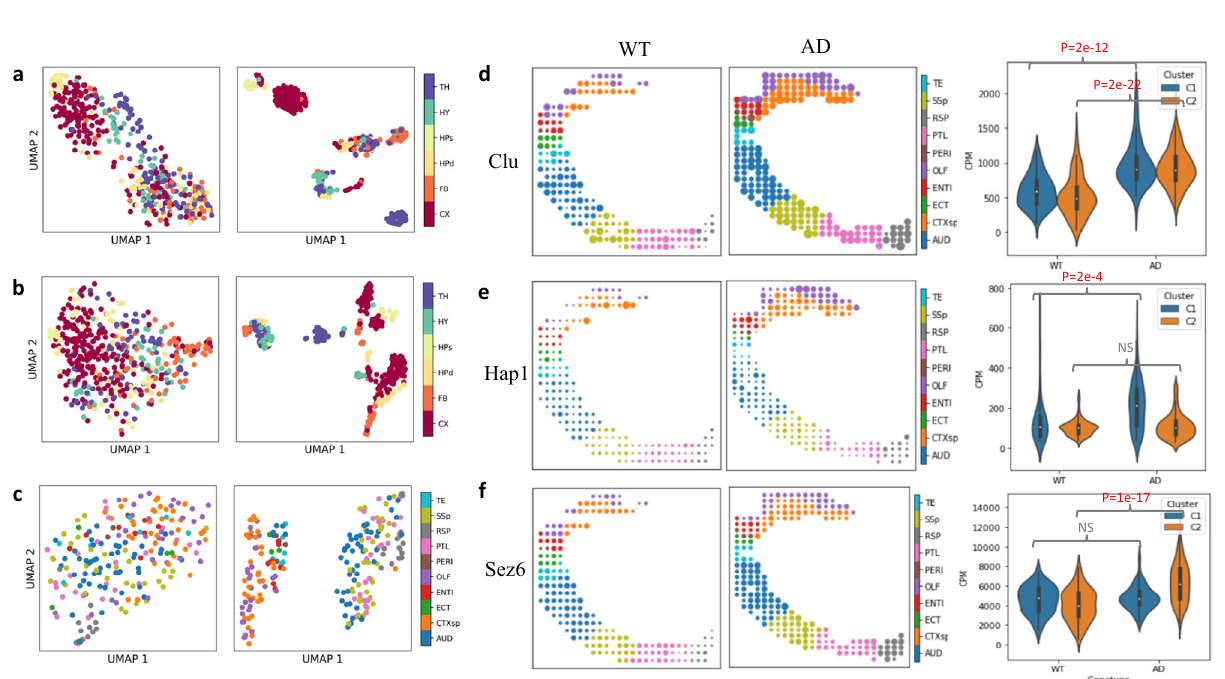
Fig. 3 | MIST outperforms other imputation methods in holdout experiments. a – b Dotplotsof( a )rootedmeansquareerror(RMSE)and( b )Pearson ’ scorrelation coef fi cient (PCC) in the fi vefold holdout experiment using multiple datasets. Each column on the X axis is an individual dataset (Supp. Table 1). Colors of dots represent different benchmarked imputation methods as shown in the legends. c Boxplot of gene-level performance of each model represented by the RMSE ( y axis). X axis groups genes by sparsity level (zero-value percentage) of 20% ( n =2078), 30% ( n =4061), 40% ( n =5761), 50% ( n =8077) and 60% ( n =6078). Colorsofboxesrepresentdifferentbenchmarkedimputationmethodsasshownin the legend. Boxplots are de fi ned with center line (median), box limits (upper and lower quartiles) and whiskers that extend at most 1.5 times of the interquartile